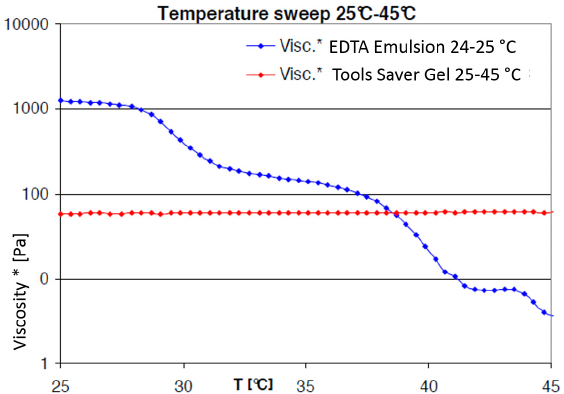
Figure 6: Comparison of viscosity between EDTA emulsion and Tool Saver Gel vs.